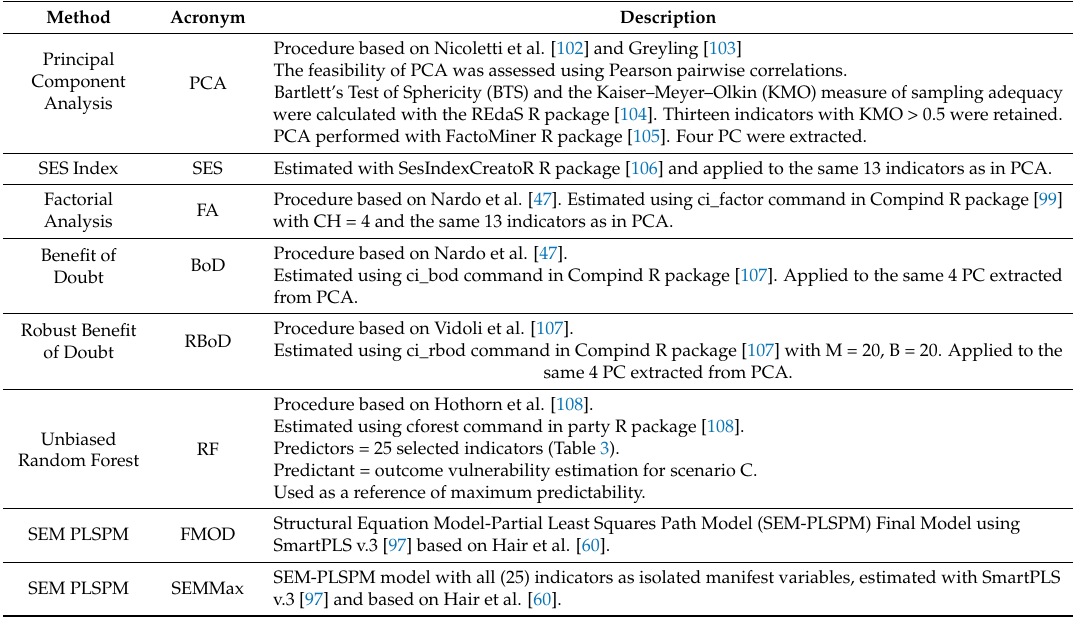
Table 5. Comparison methods for contextual vulnerability